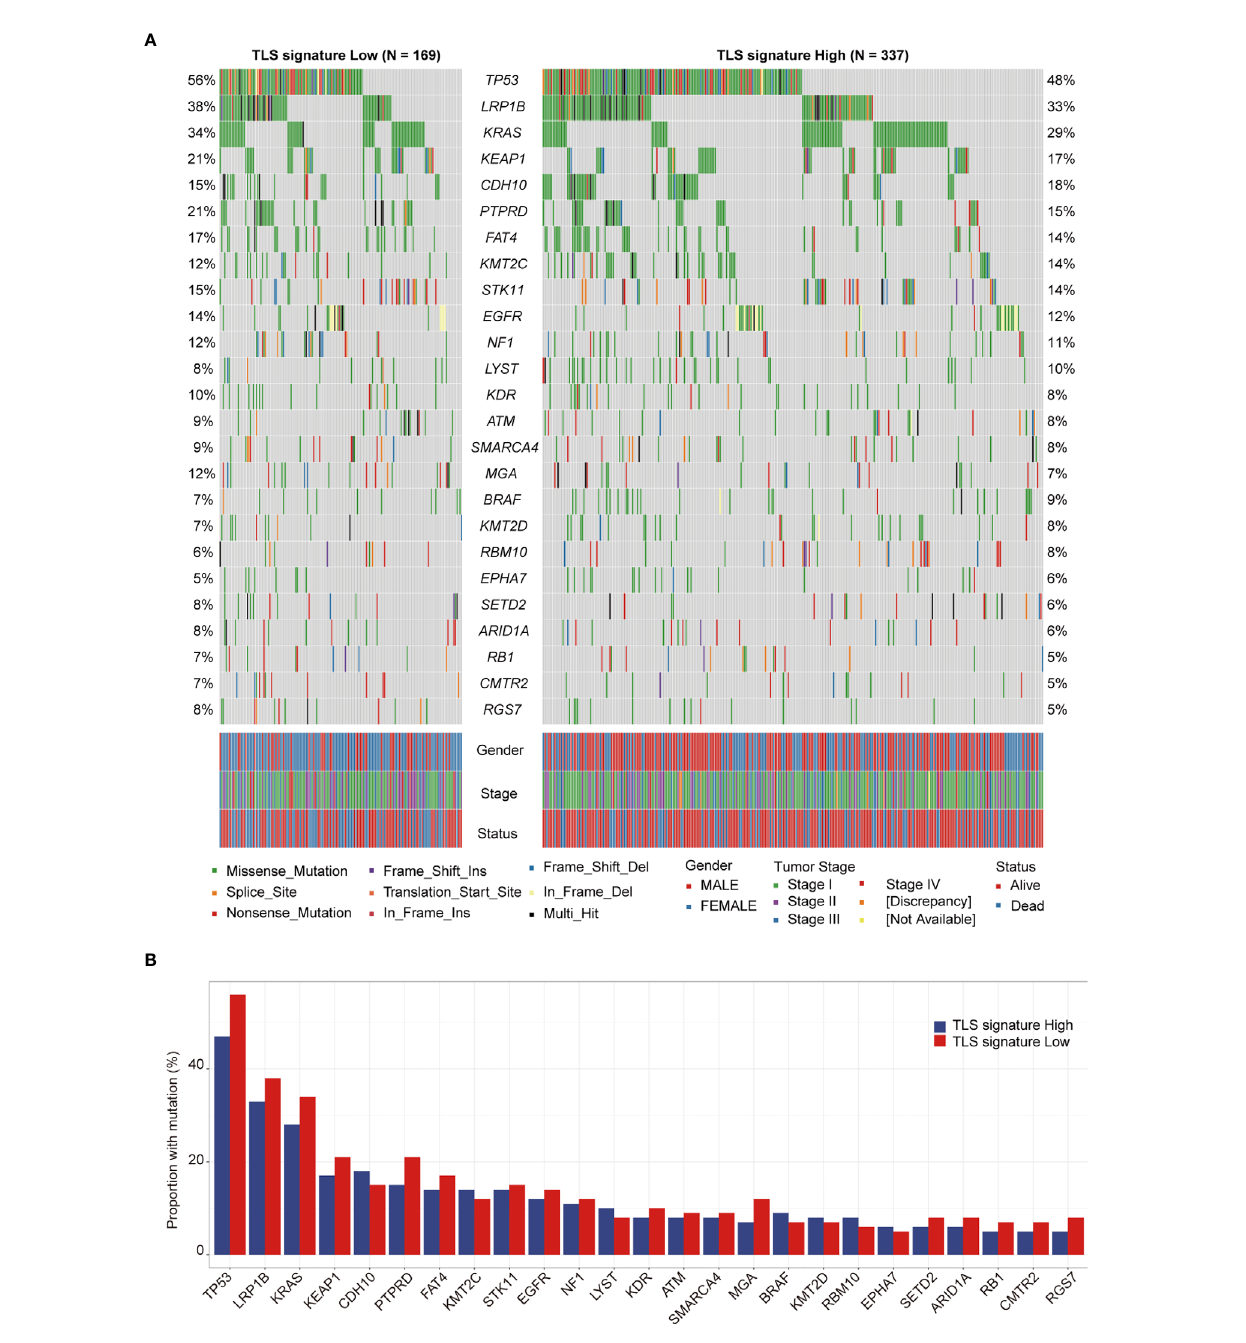
FIGURE 4 | Relationship between TLS signature and mutation status of the driver genes. (A) Differences in the landscape of driver gene mutations between the TLS signature high (n = 336) and low groups (n = 169), the OncoPlot shows the signi fi cant mutated driver genes in LUAD tumors ( ≥ 5% in both groups); (B) Differences in mutational frequencies of top driver genes ( ≥ 5% in both groups) between the TLS signature high (n = 336) and low groups (n =